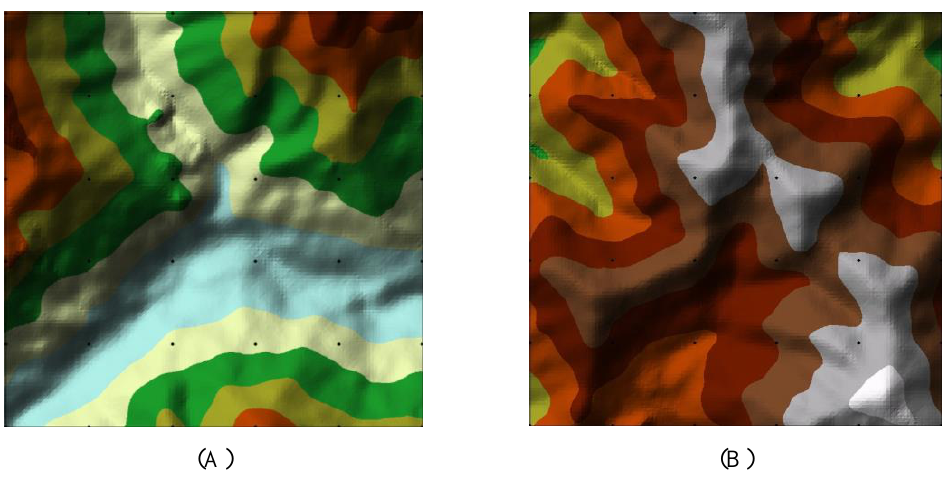
Figure 12. The locations of the sampling points before modification. ( A ) Sampling points before modification of area A; ( B ) Sampling points before modification of area B.